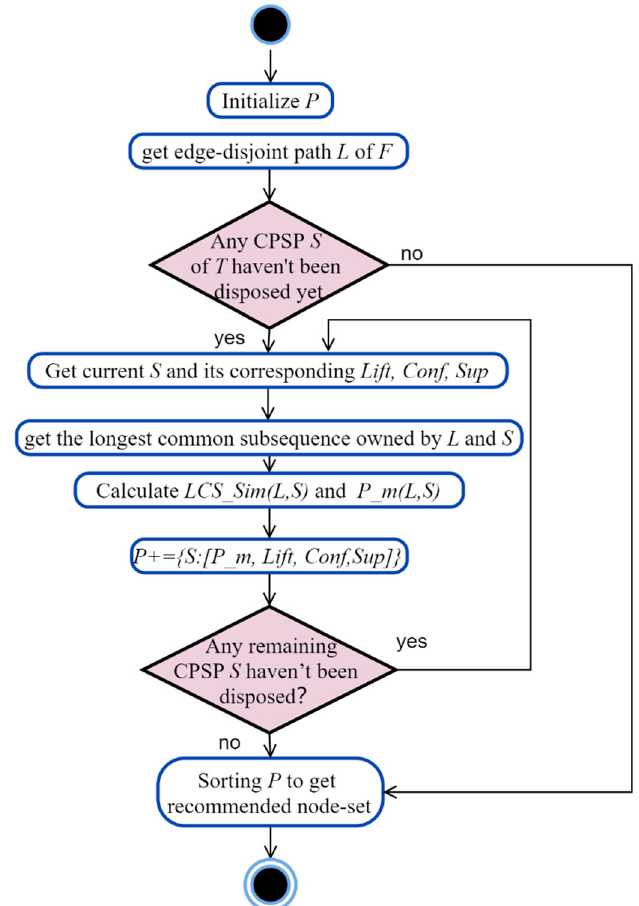
Figure 7. The process node recommendation algorithm framework.